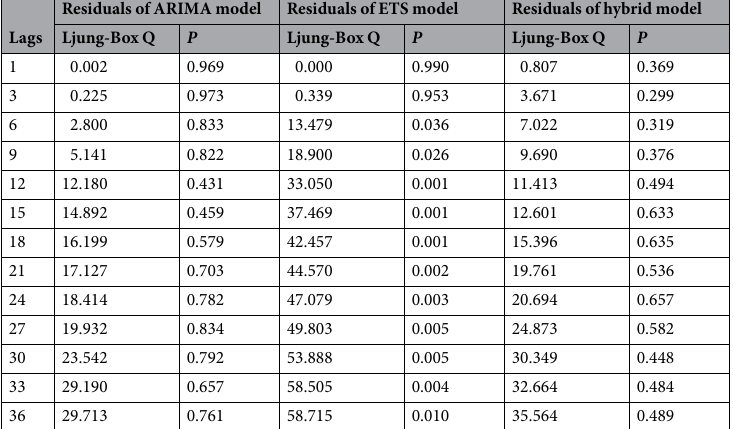
Table 1. Ljung-Box Q test of the residuals for each of the selected optimal